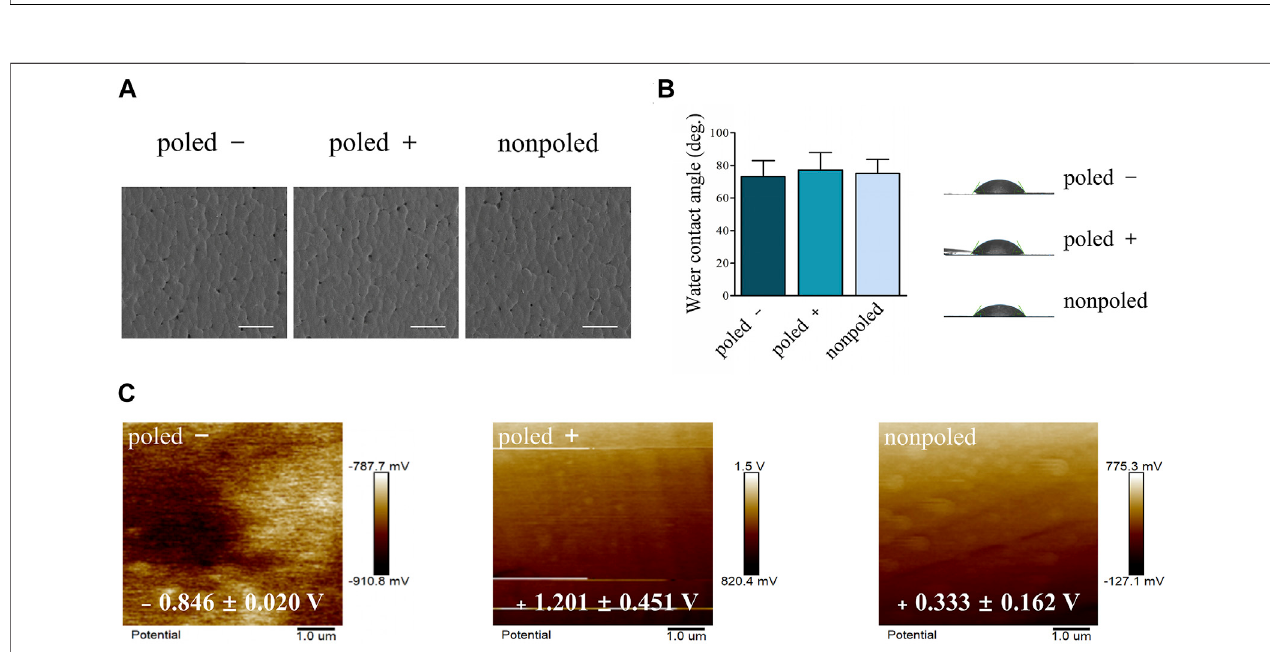
FIGURE 3 | Physical characterization of P (VDF-TrFE) membranes with different polarities. (A) Representative SEM micrographs at 500 × magni fi cation (scale bar: 50 μ m). (B) Water contact angle analysis. (C) KPFM images displaying the relative surface potential distribution of the negatively, positively, and neutrally charged P (VDF-TrFE)